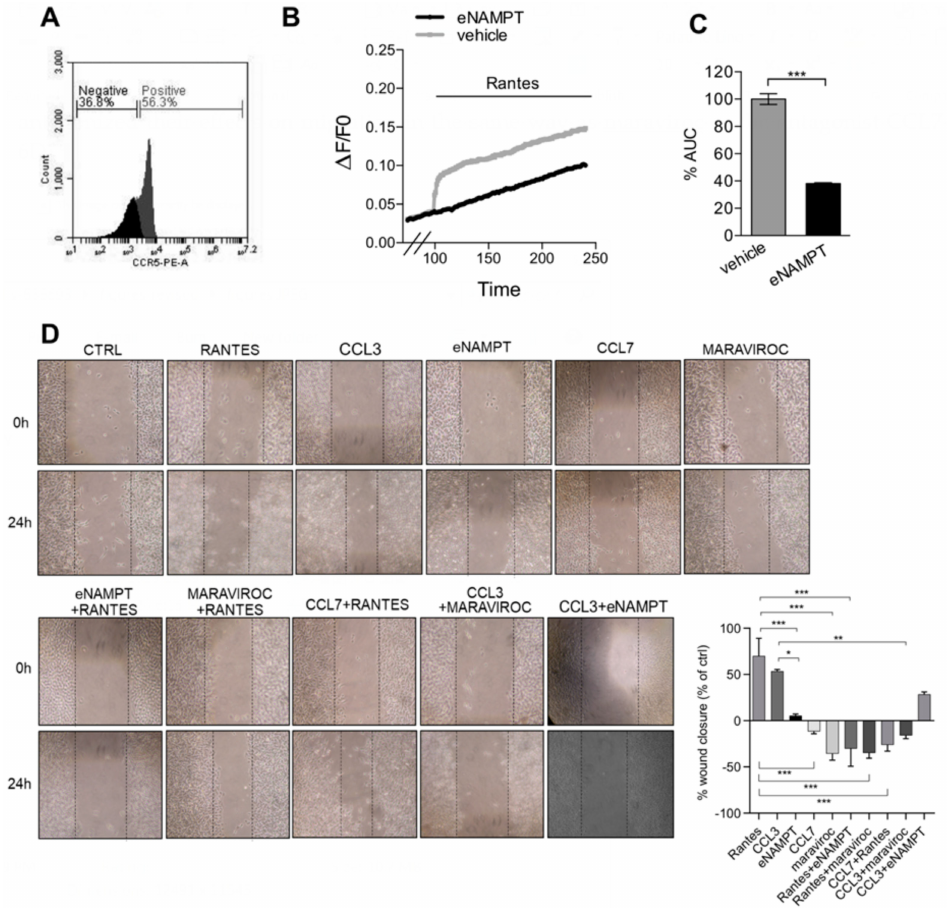
Figure 6. eNAMPT antagonizes the CCR5-mediated migration of B16 melanoma cells. ( A ) CCR5 expression in B16 cells stained with anti-mouse CCR5-PE and analyzed by flow cytometry. ( B , C ) AUC and percentage of responding cells of B16 cells loaded with FURA-2AM and pretreated with eNAMPT (500 ng / mL; 9 nM) for 100 s before the addition of RANTES (100 ng / mL; 12 nM) at 100 s. Mean ± S.E.M. of 180–210 cells from four independent experiments. ( D ) Left, representative wound healing images of B16 cells treated with vehicle, Rantes (100 ng / mL; 12 nM), eNAMPT (500 ng / mL; 9 nM) and / or maraviroc (10 µ M), and / or CCL7 (250 ng / mL; 22 nM) and CCL3 (100 ng / mL; 9.9 nM) at time 0 and after 24 h of treatment. Right, percentage of wound closure (compared to % of the control) after 24 h of treatment. Mean ± S.E.M. of six determinations from two separate experiments. * p < 0.05, ** p < 0.01, *** p <